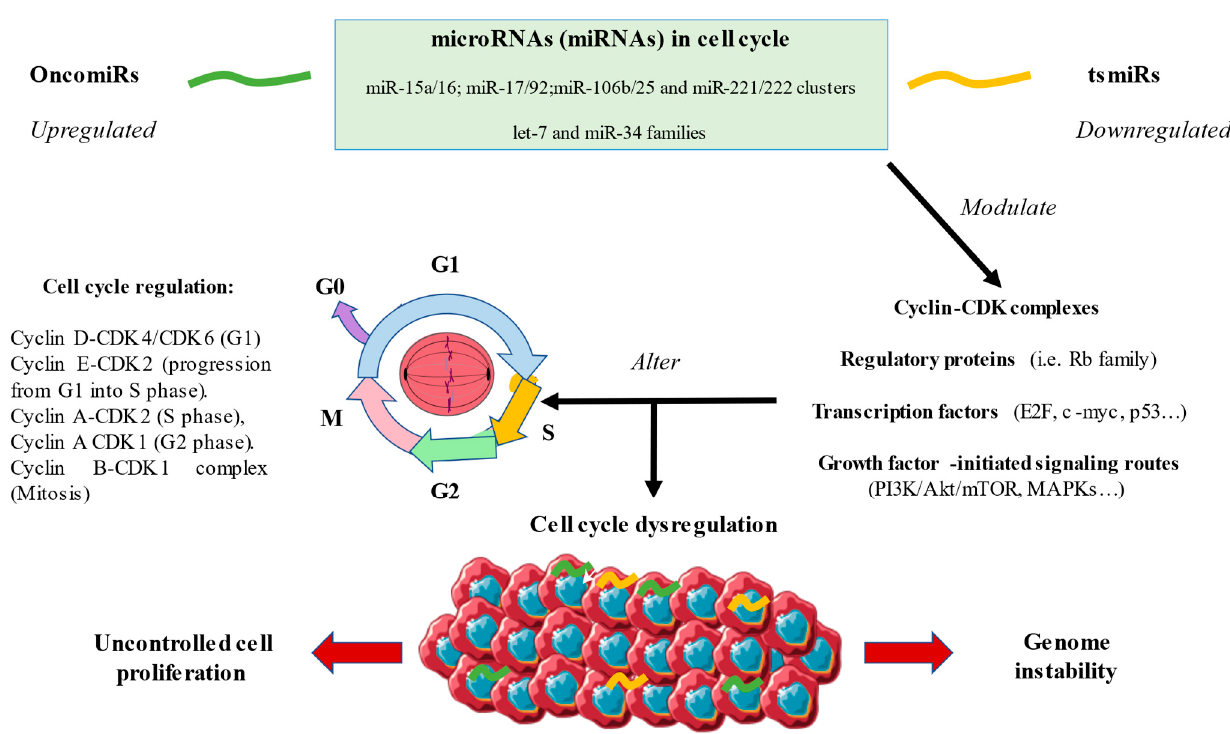
Figure 1. A general overview of the role of microRNAs in the cell cycle. As shown, various dysregulated oncogenic miRNAs (OncomiRs) and tumor-suppressive miRNAs (tsmiRs) are able to modulate a set of products involved in the control and progression of the cell cycle, therefore leading to cell cycle dysregulation. Consequently, two major hallmarks of cancer are promoted: uncontrolled cell proliferation and genome instability. Table 1. Main microRNAs implicated in cell cycle modulation, the type of cancer in which they are described and their expression and targets.